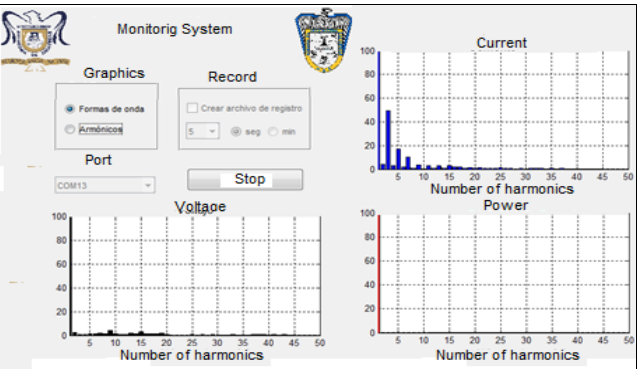
Figure 17: Harmonic components obtained through the prototype in the multilevel inverter with inductive-resistive load.